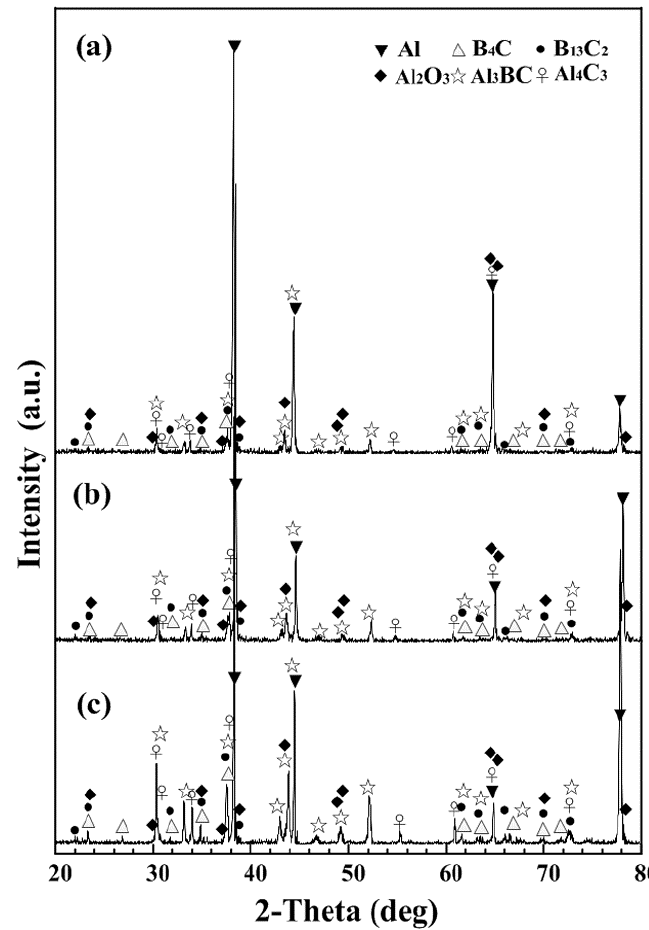
Figure 4. Phase identification of B 4 C/Al 5083 composite with ( a ) 10 wt % B 4 C content; ( b ) 20 wt % B 4 C content; ( c ) 30 wt % B 4 C content.